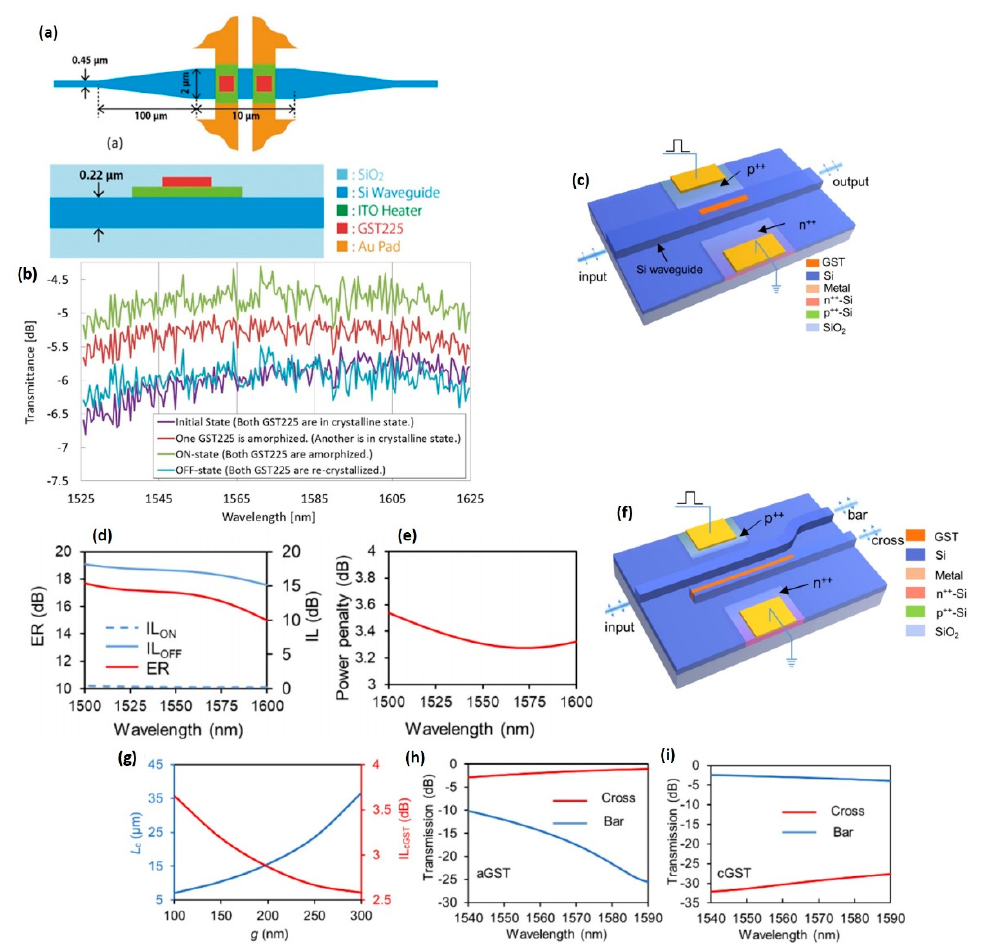
Figure 10. Switches and modulators based on chalcogenide PCM. ( a ) Schematic top view and cross-section of GST-based optical switch using current-controlled ITO heaters. ( b ) Optical transmission spectra of GST-based optical switch shown in ( a ). The spectra contain the transmission from the switch under different configurations. ( c ) Schematic of the perspective view of the modulator with GST in a slot. ( d ) On/off extinction ratio (ER) and the insertion losses of the EA modulator presented in ( c ). ( e ) Power penalty of the EA modulator shown in ( c ) as a function of wavelength along the propagation length. ( f ) Schematic of the perspective view of the 1 × 2 DC switch. GST is implanted in a slot instead of straddling the waveguide. ( g ) Coupling length of the maximum transmission in the amorphous state and the insertion loss in the crystalline state as a function of g (the gap size between the waveguides). Transmission spectra at the cross and bar ports for ( h ) amorphous GST and ( i ) crystalline GST for the switch presented in ( f ). (( a , b ) reproduced under creative commons